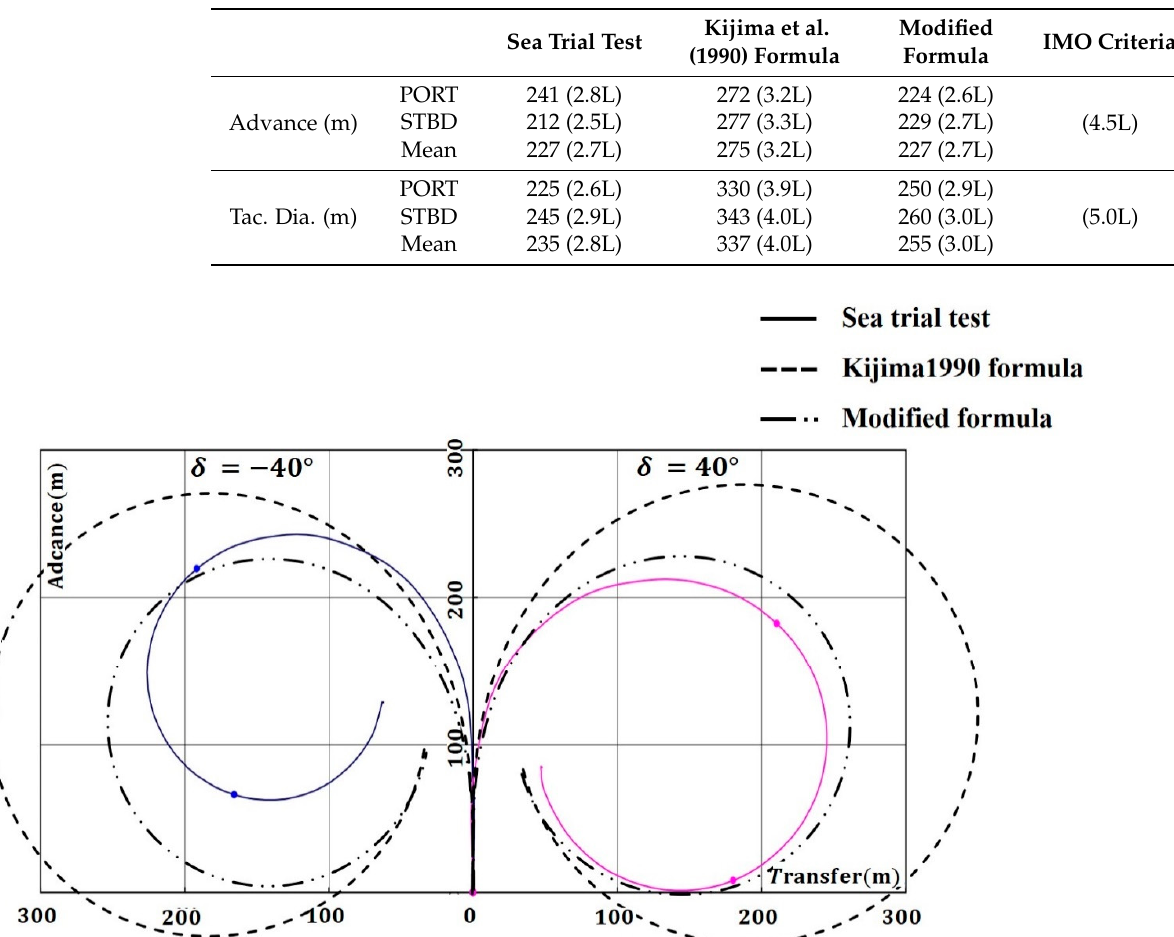
Table 7. Quantitative comparison of the turning motion test results of the target trawler.